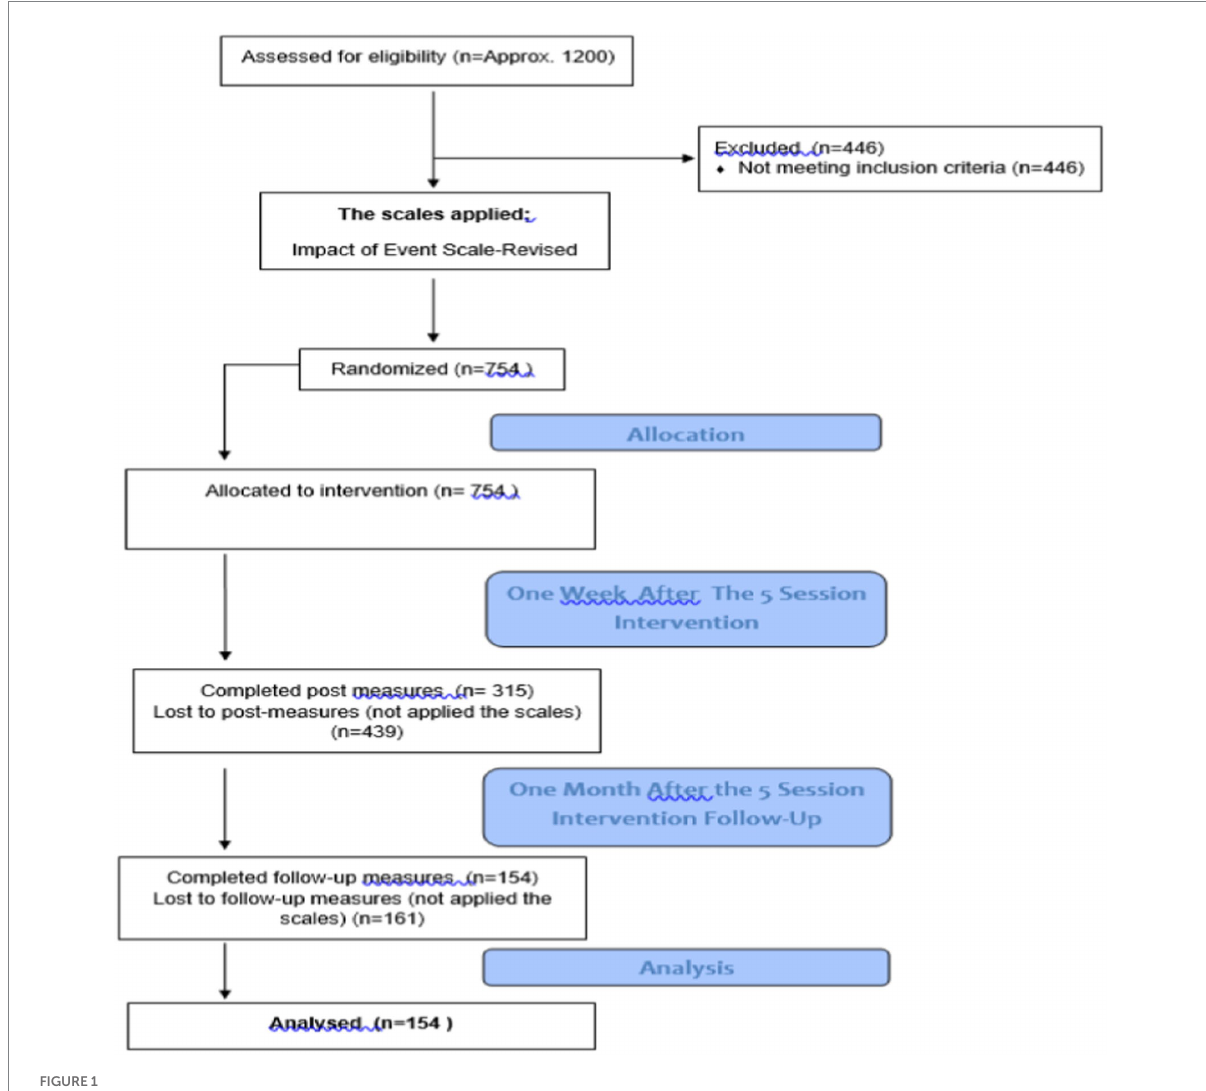
FIGURE 1 Flowchart of participants through each stage of the